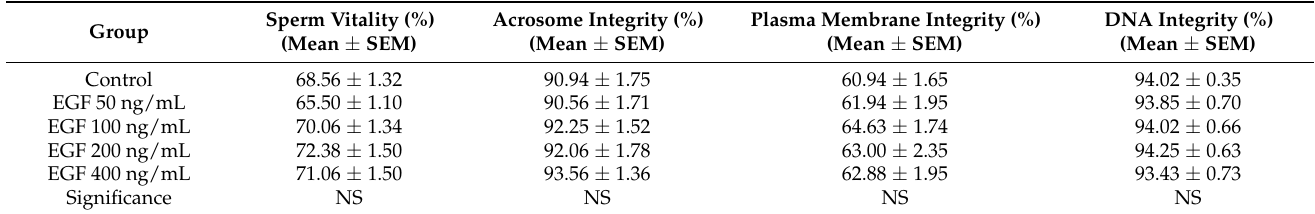
Table 4. Differences in vitality, acrosome, DNA integrity, and plasma integrity between thawed semen extended with epidermal growth factor (EGF) at different concentrations (50, 100, 200, and 400 ng/mL) and controls (without EGF) at different post-thaw times.